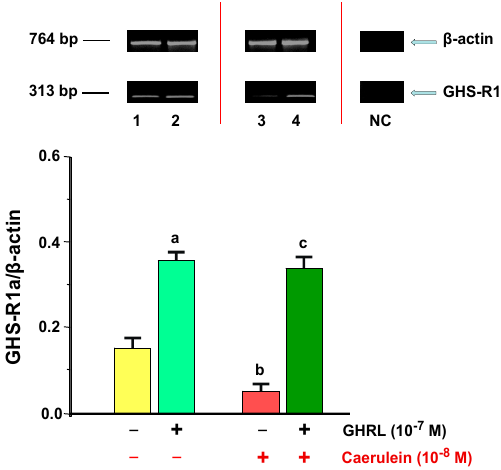
Figure 5. Analysis of the growth hormone secretagogue receptor 1a (GHS-R1a) gene expression determined by reverse transcriptase-polymerase chain reaction (RT-PCR) and densitometric analysis of GHS-R1A/ β -actin mRNA ratio in AR42J cells: (line 1) control cells incubated in caerulein-and GHRL-free solution; (line 2) cells incubated in caerulein-free solution containing GHRL at a concentration of 10 − 7 M; (line 3) cells incubated in solution containing caerulein at a concentration of 10 − 8 M without addition of GHRL; (line 4) cells incubated in solution containing caerulein at a concentration of 10 − 8 M and GHRL at a concentration of 10 − 7 M. NC = negative control. Reference gene: β -actin. a,b p < 0.05 compared to control cells incubated in caerulein-and GHRL-free solution (line 1); c p < 0.05 compared cells incubated in solution containing caerulein without addition of GHRL (line 3). In each experimental group, the number of observations was at least 6.